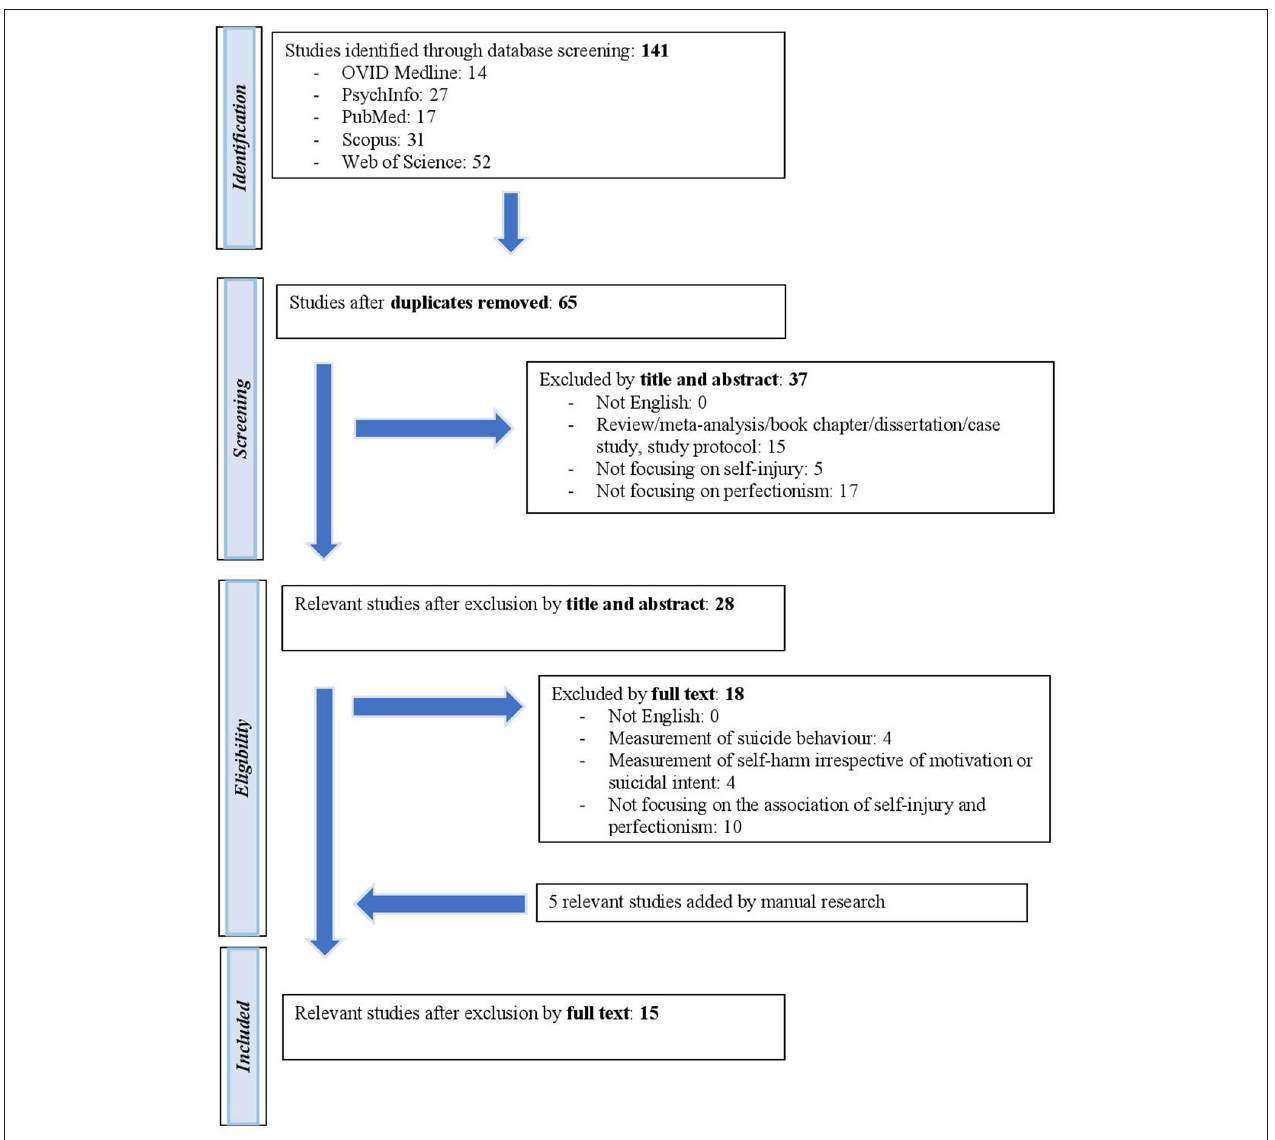
FIGURE 1 | PRISMA flowchart of inclusion-exclusion